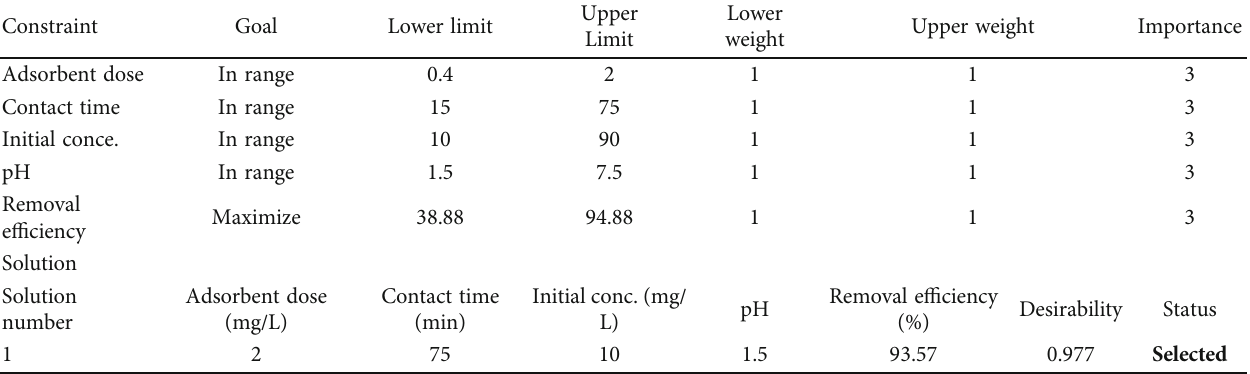
Table 9: Validation of adsorption process variables under optimum conditions.